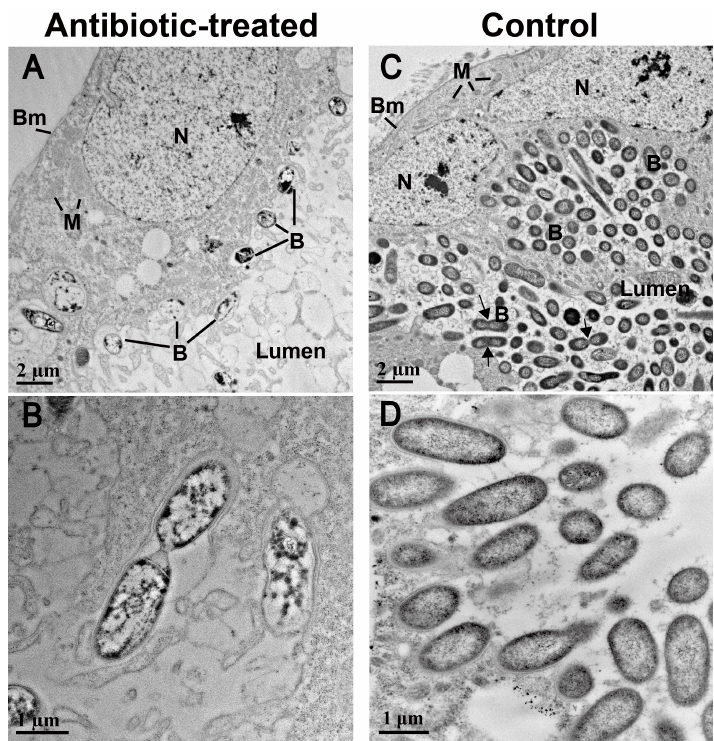
Figure 4. Transmission electron microscopy of midgut crypts dissected from the antibiotic-treated and control Blissus insularis fifth instars. ( A ) The crypts of antibiotic-treated B. insularis . Only a few rod-shaped bacteria (denoted as B) were present in the crypt lumen; ( B ) The enlarged micrograph of bacteria exhibiting abnormal shape; ( C ) The crypts of control B. insularis . Numerous bacteria were present in the crypt lumen and were dividing by binary fission (indicated by arrows); ( D ) The enlarged micrograph of bacteria exhibiting normal shape. Abbreviations: B, symbiotic bacterium; Bm, host crypt basement membrane; N, host crypt nucleus; M, host crypt mitochondrion.